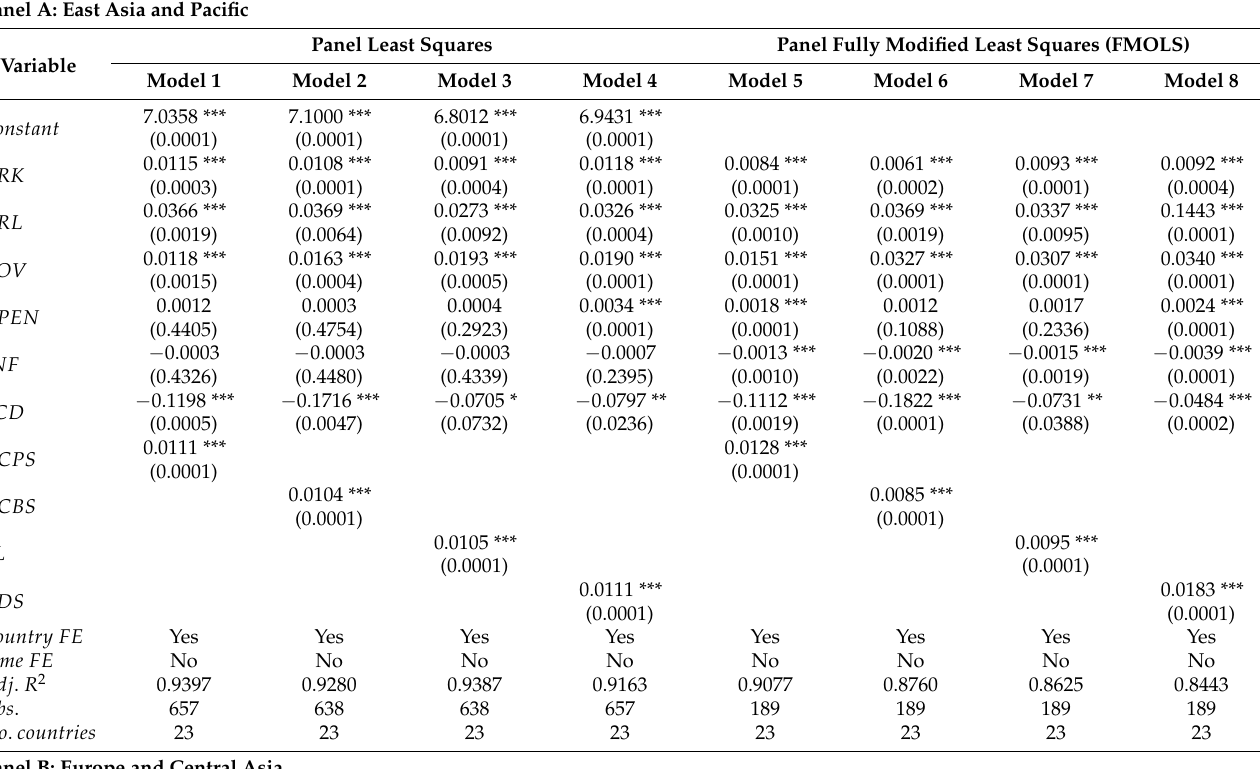
Table A3. Economic growth regressions for geographic